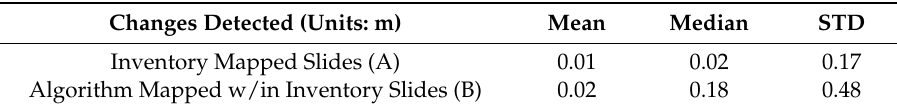
Table 3. Statistics of vertical changes detected; (A): vertical changes detected within the inventory mapped landslides (reference), and (B): vertical changes detected by the algorithm within the inventory mapped landslides.